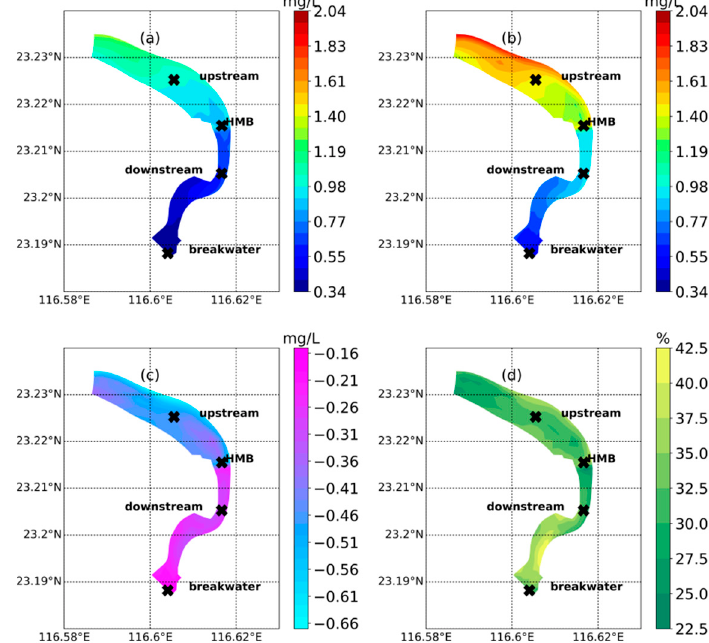
Figure 3. The averaged ammonia concentration for a spring–neap tidal cycle in the tide-receiving scenario ( a ), non-tide-receiving scenario ( b ), and the comparison between the two scenarios (tide-receiving scenario- non-tide-receiving scenario) ( c ). The relative change proportion is plotted in ( d ) (tide-receiving scenario minus non-tide-receiving scenario) / non-tide-receiving scenario).